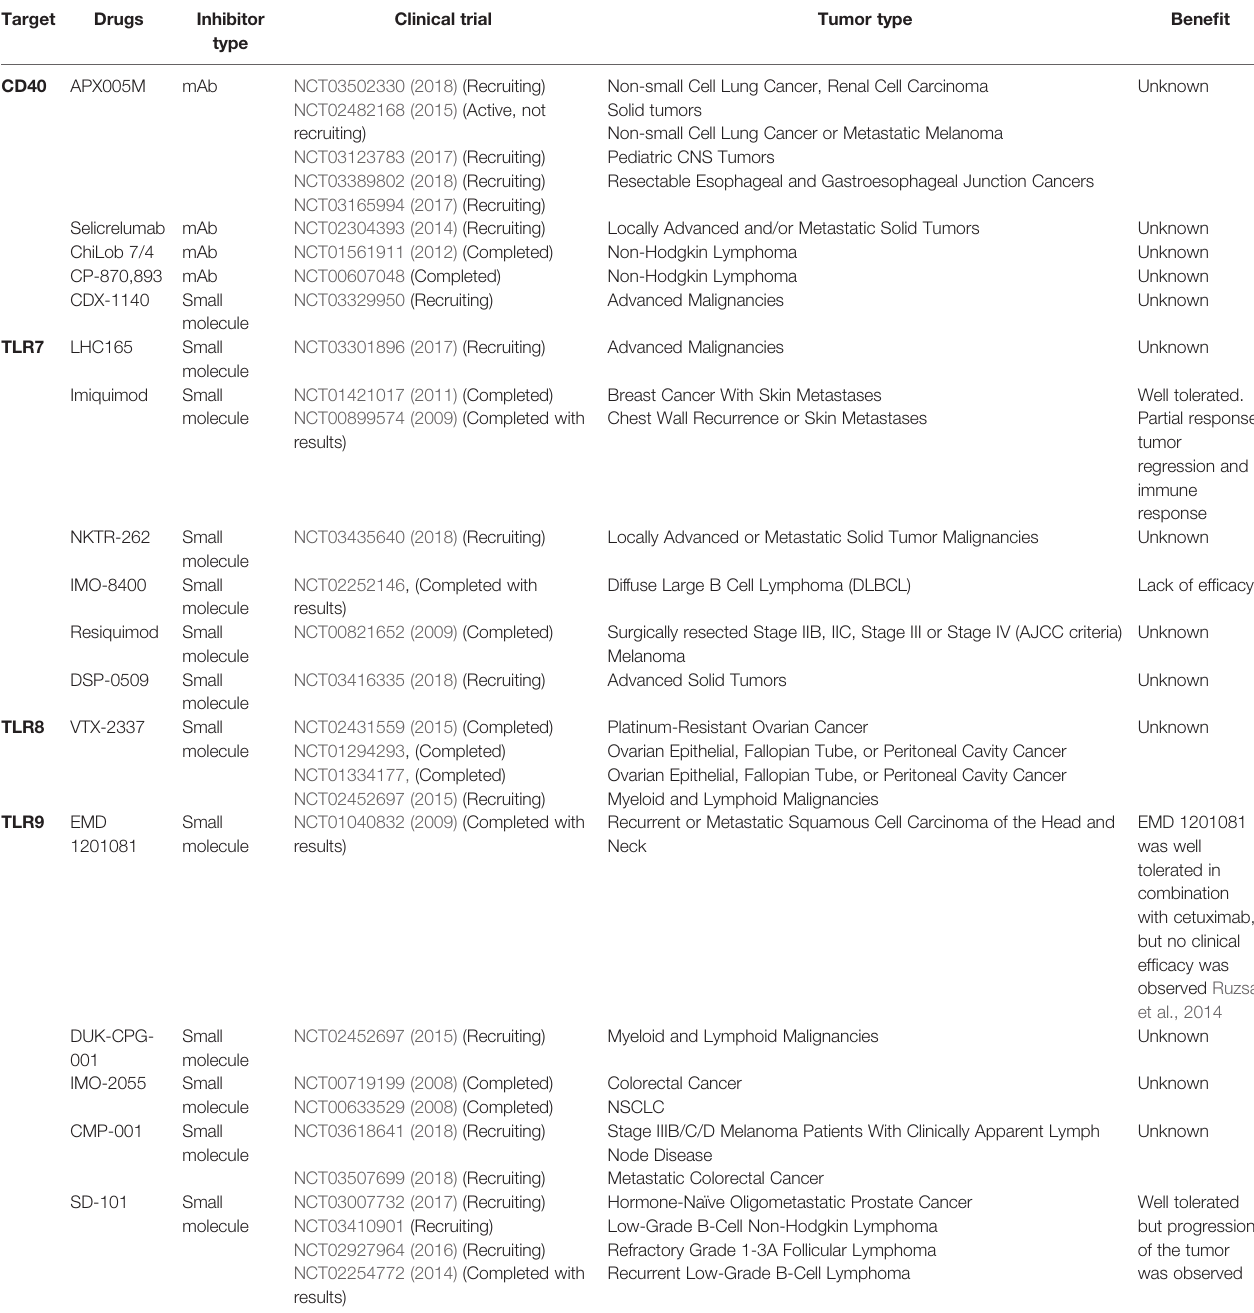
TABLE 2 | Clinical trials with toll-like receptor (TLR) agonists for macrophages reprogramming.